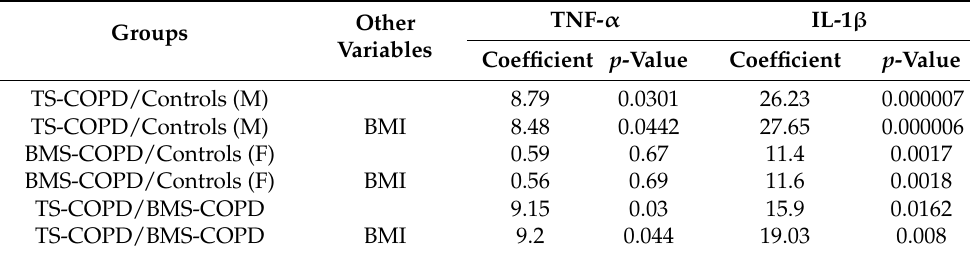
Table 3. Linear regression analysis for the cytokines as dependent variable and TS-COPD and BMS-COPD groups with BMI as independent